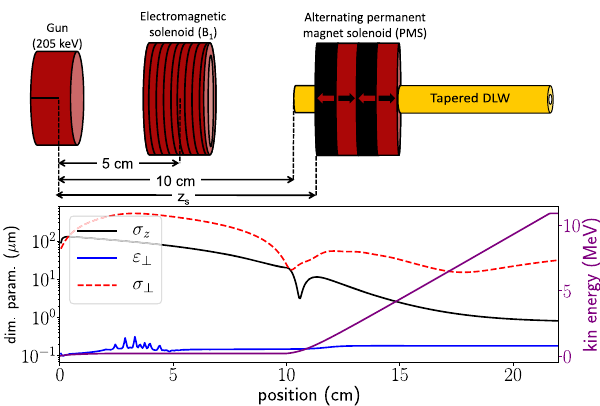
FIG. 1. Diagram of the accelerator concept (top) and corre- sponding evolution of the bunch ’ s transverse emittance ( ε r ), rms transverse beam size ( σ r ), longitudinal bunch length ( σ z ) (all left axis) and the kinetic energy (right axis) along the accelerator beamline (bottom). The example corresponds to an operating point ð ϕ ; E 0 Þ ¼ ð 79 . 3 deg ; 106 . 875 MV = m Þ ; see text for